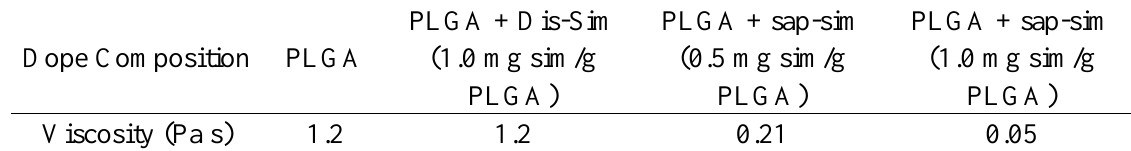
Table 1. Viscosities of membrane casting dopes.